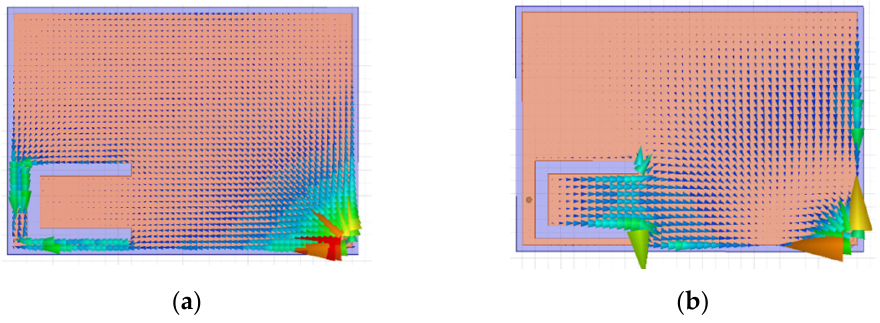
Figure 10. Surface current distribution with the shorting pin and one of the U-slots at ( a ) 402.5 MHz and at ( b ) 2.45 GHz.